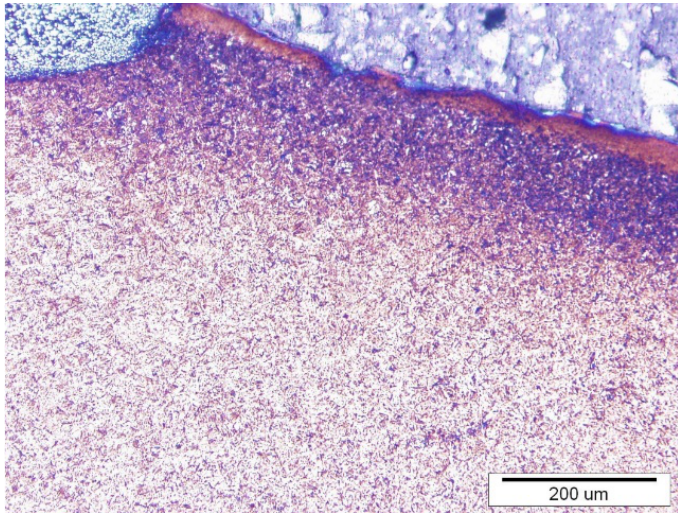
Figure 16. Microscopic photo of the tip of the tooth, etched with Nital.